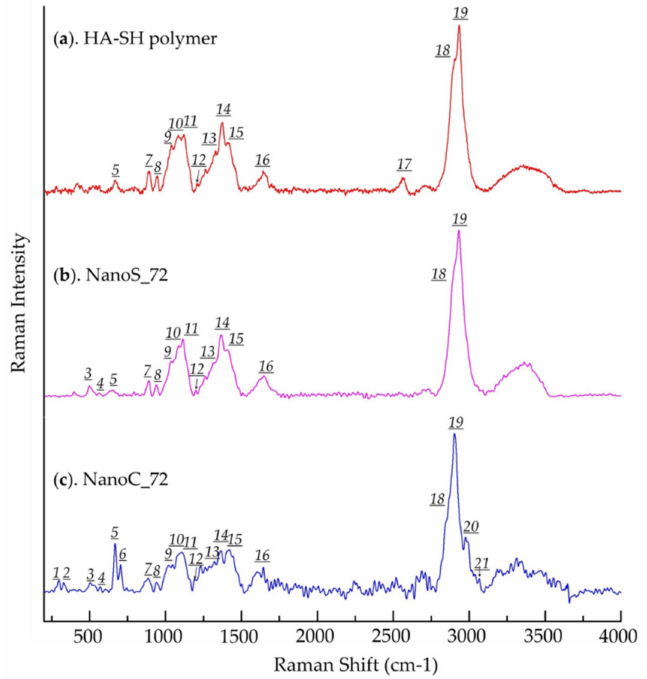
Figure 7. Raman spectra (RS) of ( a ). HA-SH polymer; ( b ). NanoS_72 and ( c ).